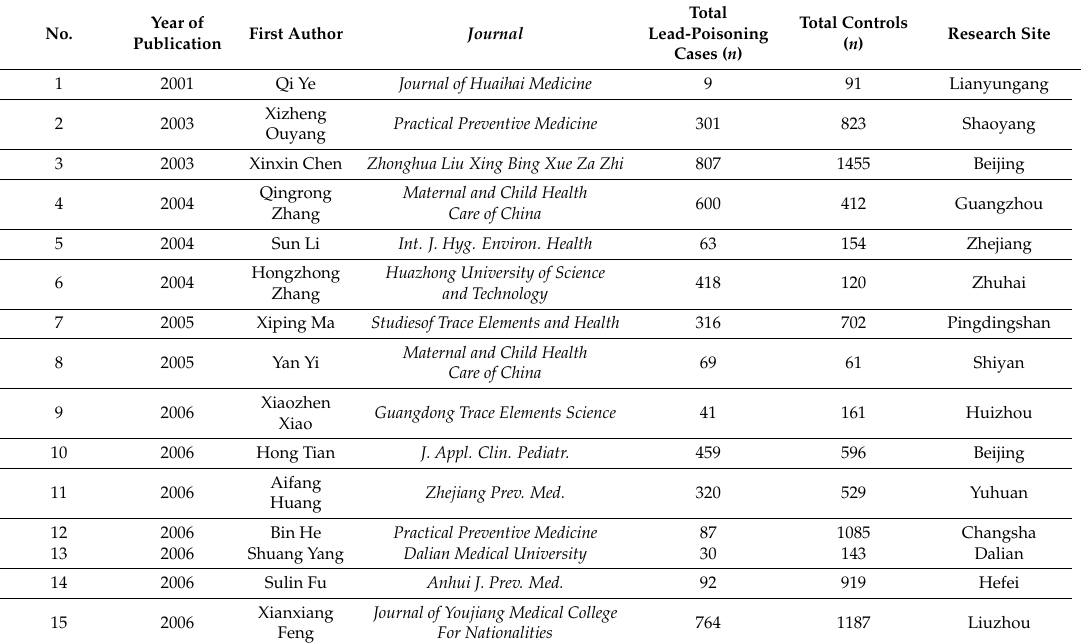
Table 1. Basic characteristics of the studies in this